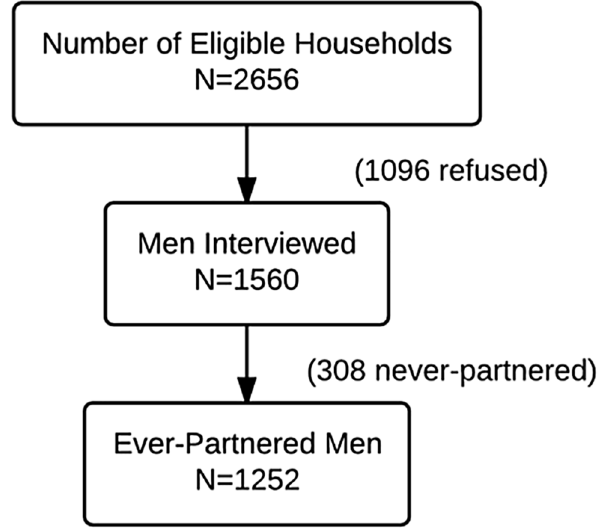
Fig 1. Sri Lankan Men ’ s eligibility and participation by ever being partnered, UN Multi-Country Study on Men and Violence in Asia and the Pacific, Sri Lanka, 2011 – 2012